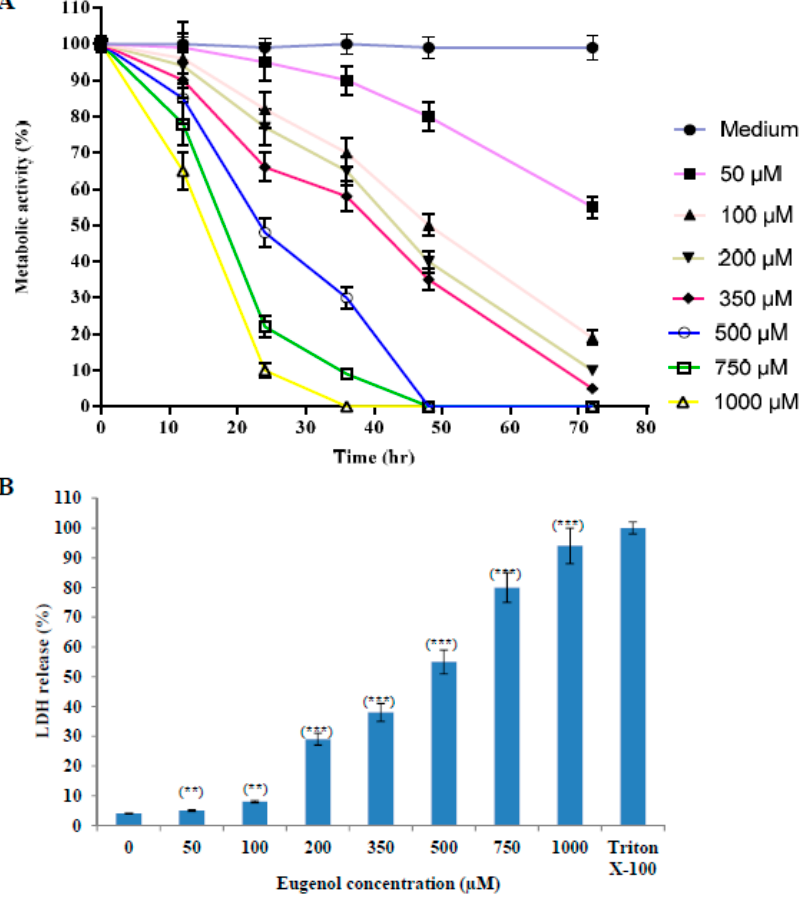
Figure 1. Eugenol cytotoxicity effect on HeLa cells. ( A ) Effect of eugenol on the proliferation of HeLa cells is concentration- and time-dependent. Proliferation of HeLa cells treated, in triplicate, with different concentrations (50, 100, 200, 350, 500, 750, and 1000 µM) of eugenol for different time intervals was estimated by CCK-8 and expressed as a percentage relative to that of cells cultured in medium only. Data represent mean ± standard deviation (SD). CCK-8, Cell Counting Kit-8. ( B ) Eugenol increases LDH enzyme leakage in HeLa cells in a concentration-dependent manner. HeLa cells were treated, in triplicate, with different concentrations (0–1000 µM) of eugenol for 24 h. LDH release (cytotoxicity) was expressed as a percent relative to that of 10% Triton X-100-treated cells. Data represent mean ± SD. Significant difference was analyzed by one-way ANOVA test, where ** p < 0.01 and *** p < 0.001 compared to HeLa cells treated with 0 µM eugenol. LDH, lactate dehydrogenase.